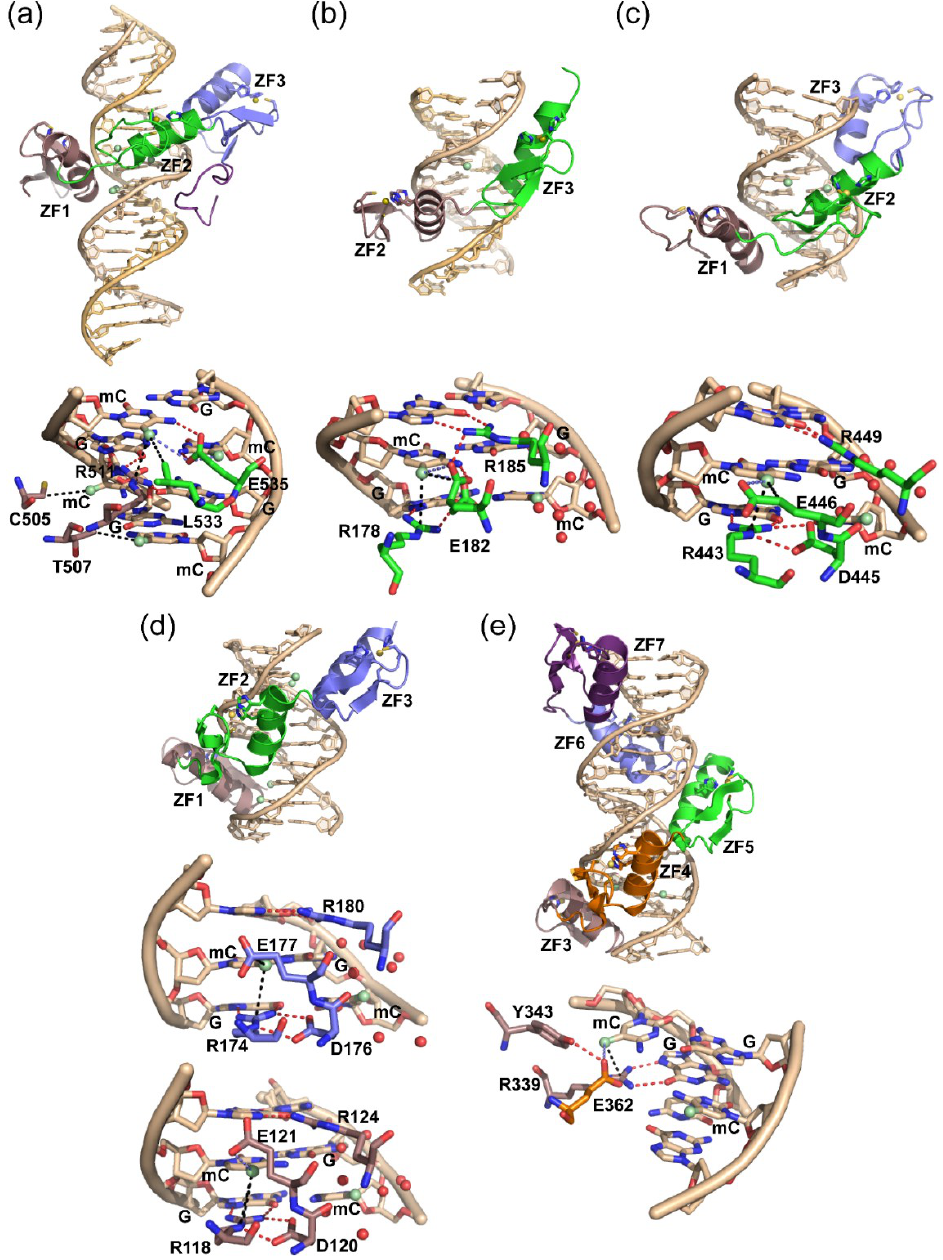
Figure 2. High-resolution crystal structures for members of the ZF MBP family in complex with their respective methylated DNA targets. ( a ) Human ZBTB33 in complex with a methylated DNA sequence derived from the E - cadherin promoter (PDB 4F6N); ( b ) mouse Zfp57 in complex with a methylated DNA sequence present in imprinting control regions (PDB 4GZN); ( c ) mouse Klf4 (Krüppel-like factor 4) in complex with its cognate methylated DNA sequence (PDB 4M9E); ( d ) human Egr1 (growth response protein 1) in complex with its cognate methylated DNA sequence (PDB 4X91); ( e ) human CTCF (CCCTC-binding factor) in complex with a methylated version of its core recognition sequence (PDB 5T00). Red spheres indicate water molecules. Red dotted lines denote classical hydrogen bond interactions; blue dotted lines indicate CH ··· O type hydrogen bonds, and black dotted lines designate van der Waals interactions. For each zoomed-in image, the amino acid side chain color designation matches that of the ZF from which it is derived in the full structural image depicted